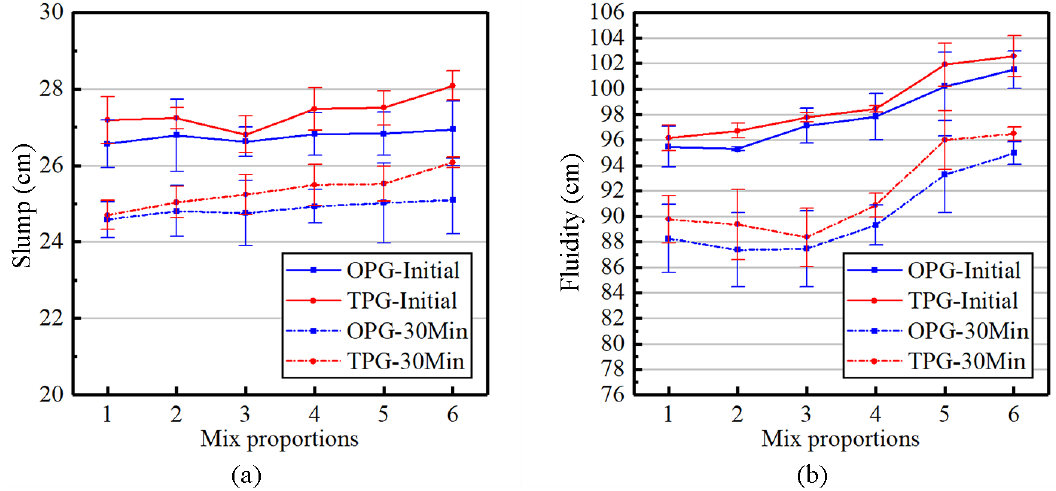
Figure 8. Workability of the mixtures with OPG and TPG. ( a ) Values of slump; ( b ) values of fluidity.